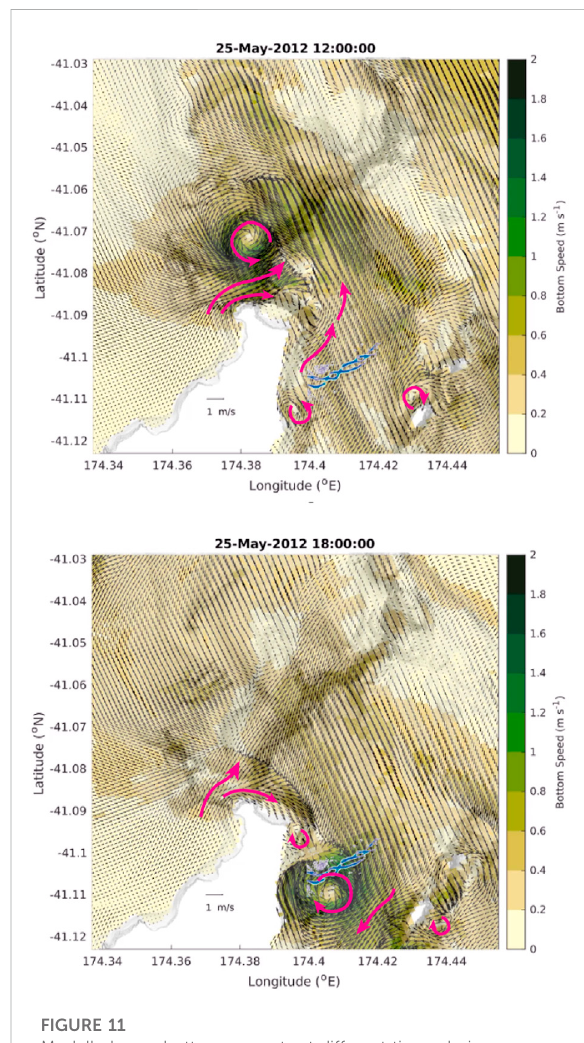
FIGURE 11 Modelled near-bottom currents at different times during a tidal cycle on the 26th – 27 May 2012 (when in-situ observations were recorded (see details in Had fi eld et al., 2014)), with the bedforms SE of Cape Koamaru (bedform crests delineated in blue) overlapped. Magenta arrows indicate predominant near- bottom current direction in different sites, highlighting the relationship between eddy formation, coastal morphology, and seabed